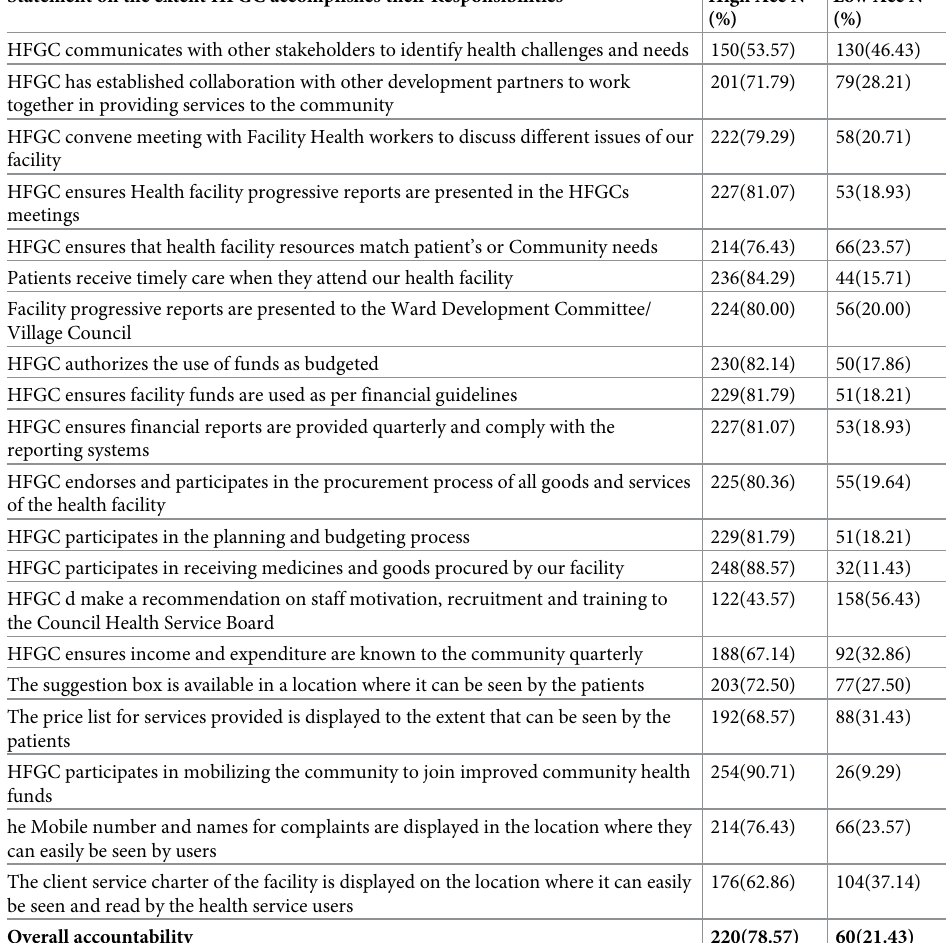
Table 4. Perceived accountability of HFGCs in the public primary health facilities implementing DHFF in Tanza- nia N = 280. Statement on the extent HFGC accomplishes their